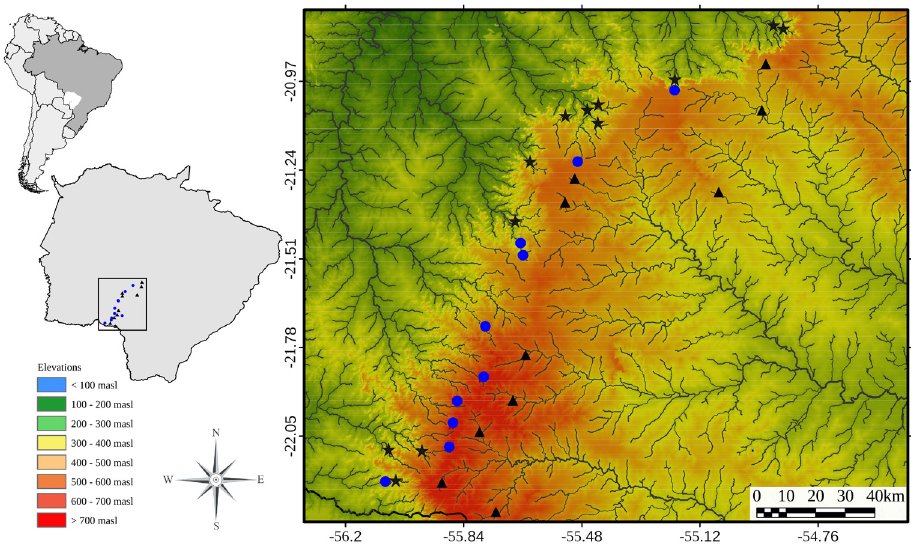
FIGURE 1 | Headwater streams sampled in the Paraná and Paraguai River basins. Blue circles represent streams of the Paraguai basin, and black triangles represent streams of the Paraná basin. The stars represent waterfalls. The color indicates the variation in